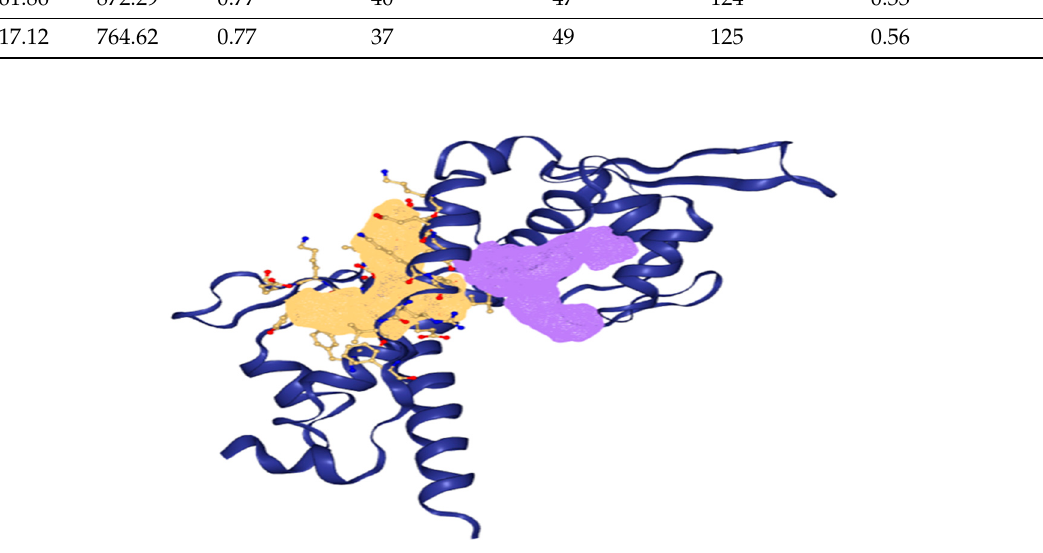
Figure 1. The 3D Structure of MAGE-A build using Swiss Model.